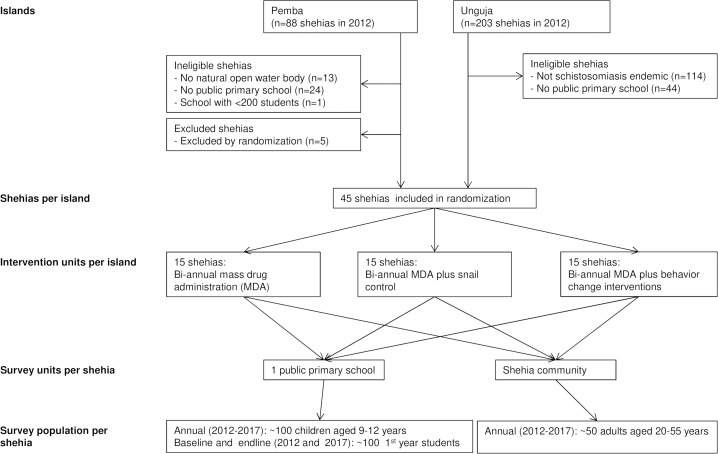
Flowchart of study design.